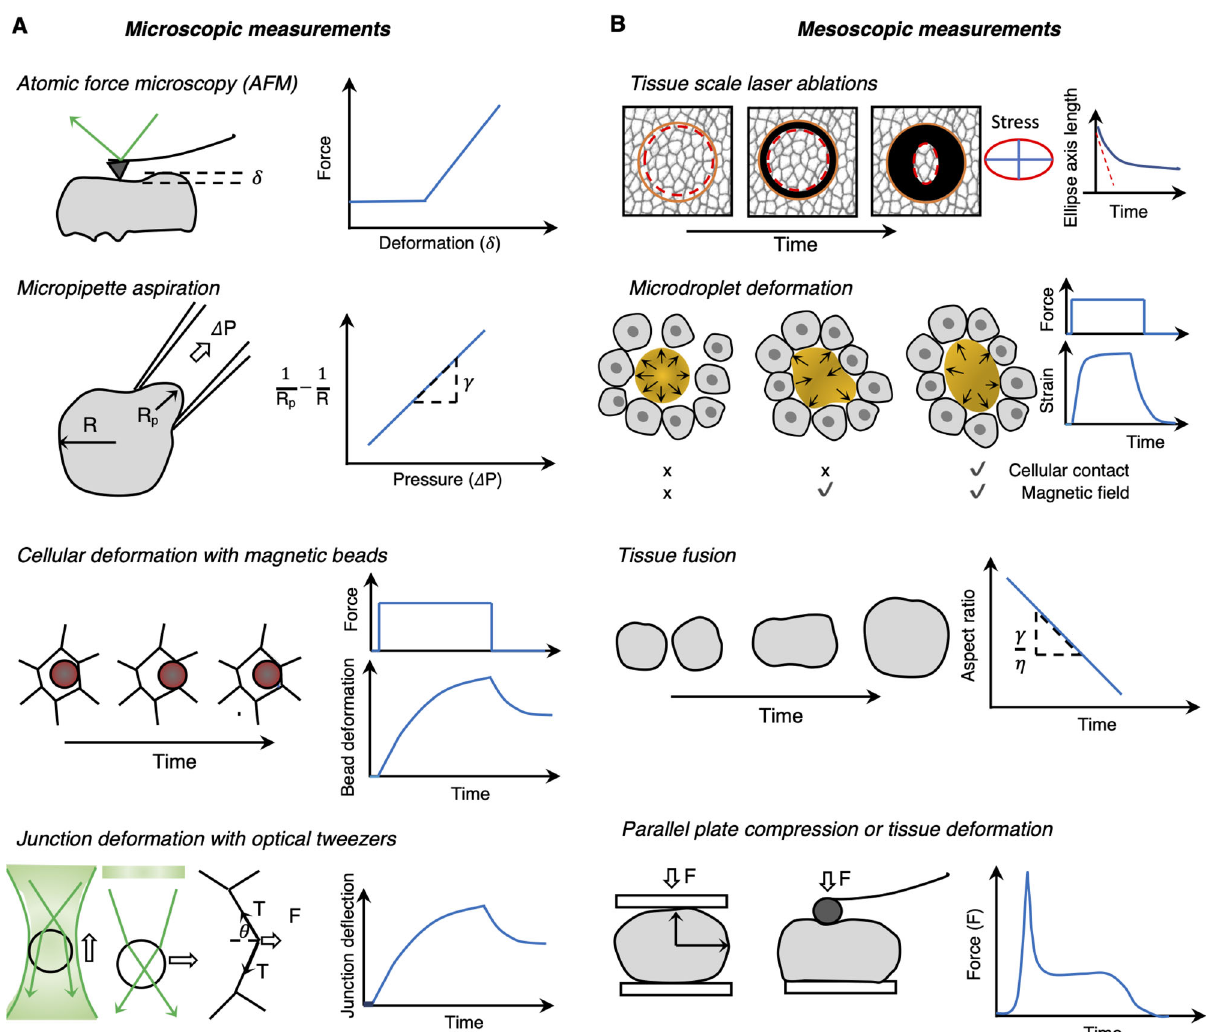
Fig. 5 Rheological measurements (contact-based methods) to detect phase transitions in situ. A The class of microscopic techniques aim to probe rheology at the cellular scale where the measurements typically require a mechanical apparatus or the insertion of force probes and the determination of force-deformation curves. B Mesoscopic rheological measurements aim to measure supracellular properties relying on the same principle of utilizing a force-deformation curve but induce deformation at the multicellular